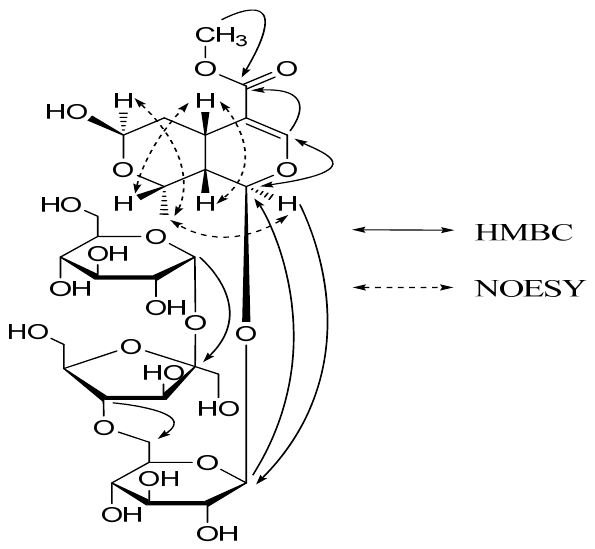
Figure 2. Key HMBC correlations of compound 1